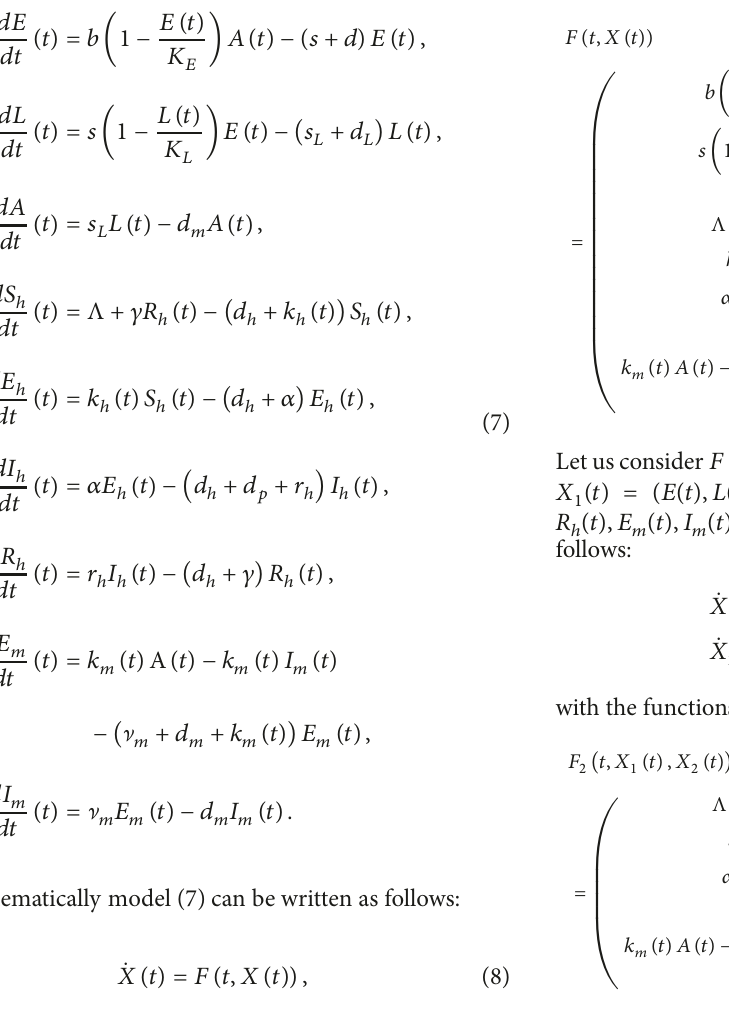
(𝑡)) 𝑇 . The function 𝐹 : R × R 9 → R 9 is 𝐶 ∞ ( R 9 ) and 𝐼 𝑚 + defined